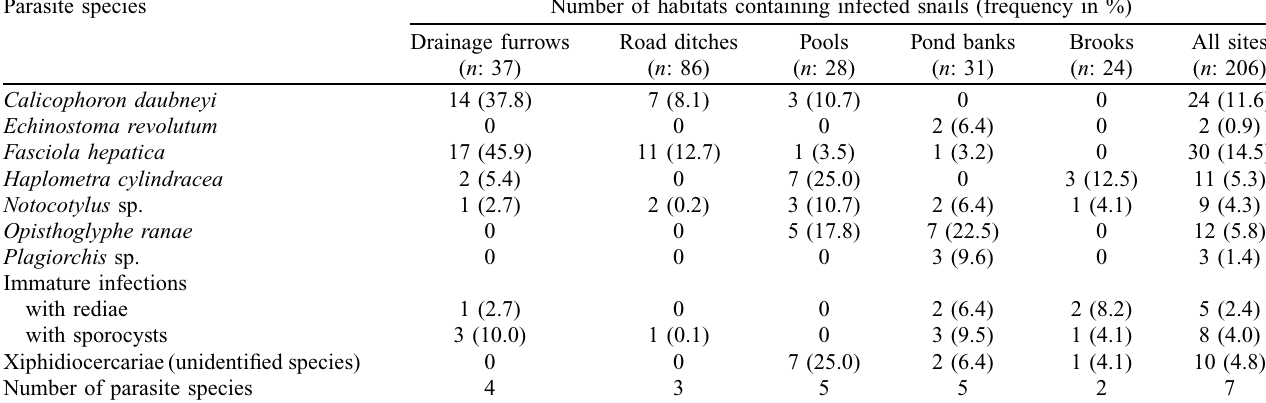
Table 1. Frequency of sites colonized by Lymnaea glabra and containing infected snails in relation to the type of habitat and digenean species. n , total number of habitats colonized by the lymnaeid. Parasite species Number of habitats containing infected snails (frequency in